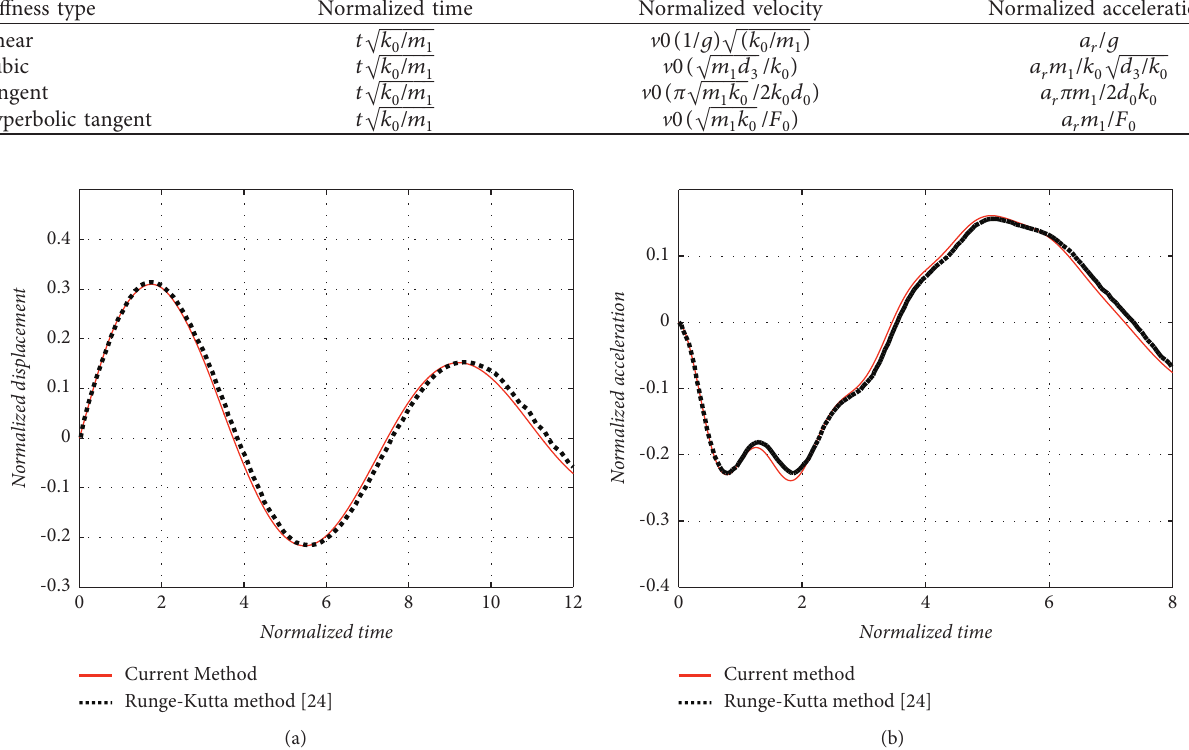
Figure 3: Responses of a packaging system with cubic stiffness predicted by the proposed method and the Runge–Kutta method [24]. (a) Displacement. (b) Acceleration.